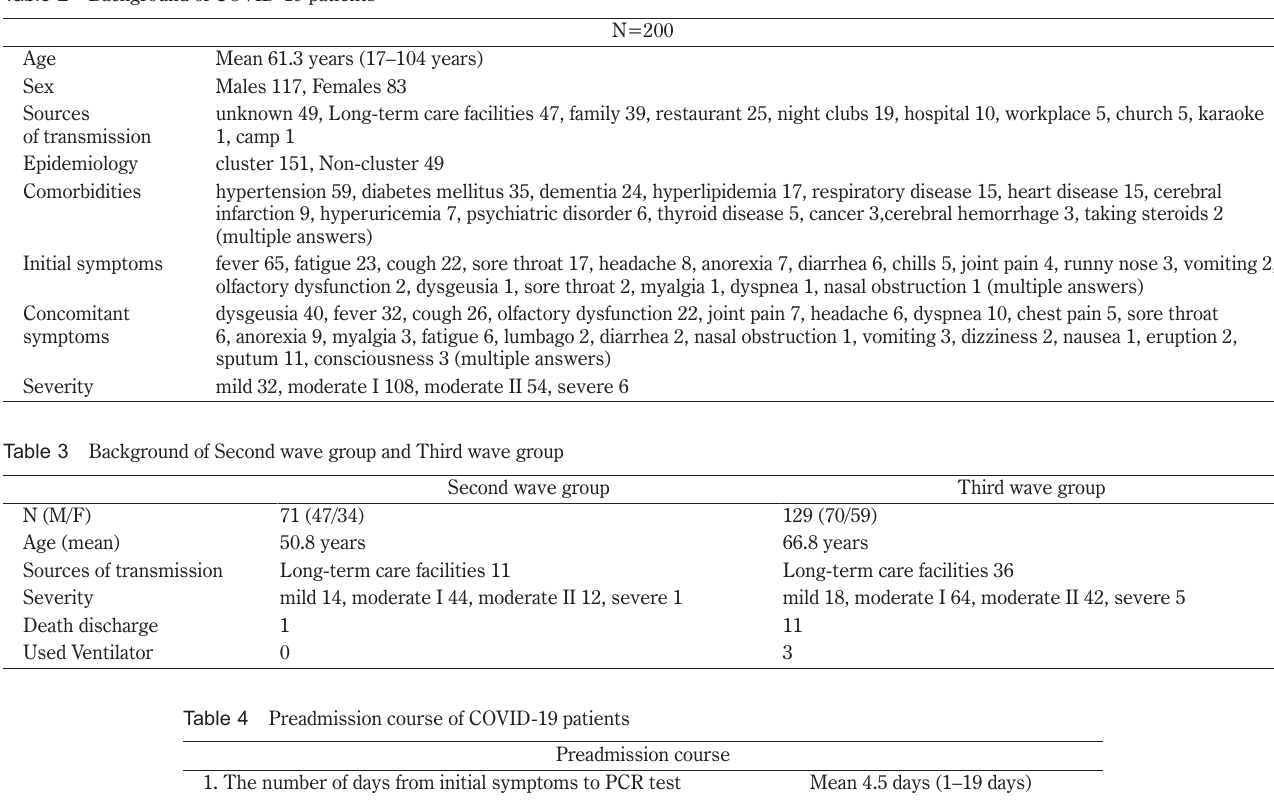
Figure 3 Number of COVID-19 inpatients from Okazaki city or outside the region. In the second wave, only 9 patients from outside the region were hospitalized in August, but in the third wave, the number of inpatients increased to 8 patients in November, 22 patients in December, and 23 patients in January. Silver bar is number of hospitalized patients from Okazaki city, dark brown bar is number of hospitalized patients from outside the region. Table 2 Background of COVID-19 patients